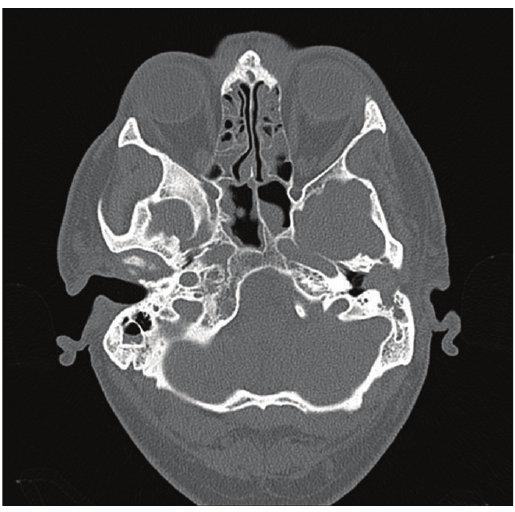
Figure1:CTpetrousbonesaxialimageshowingleftmiddleearsoft- tissue mass.